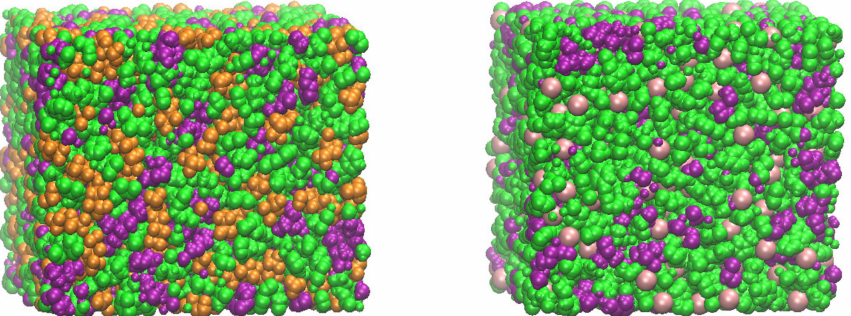
Figure 3. Snapshots of the PILs generated with EIM2 cationic monomers and different anions, TFSI − (left-hand side) and Cl − (right-hand side), obtained at 300 K. Van der Waals representations of the molecules are employed, where green, purple, orange, and pink symbols represent the atoms of the EIM2, TAEA, TFSI − , and Cl −